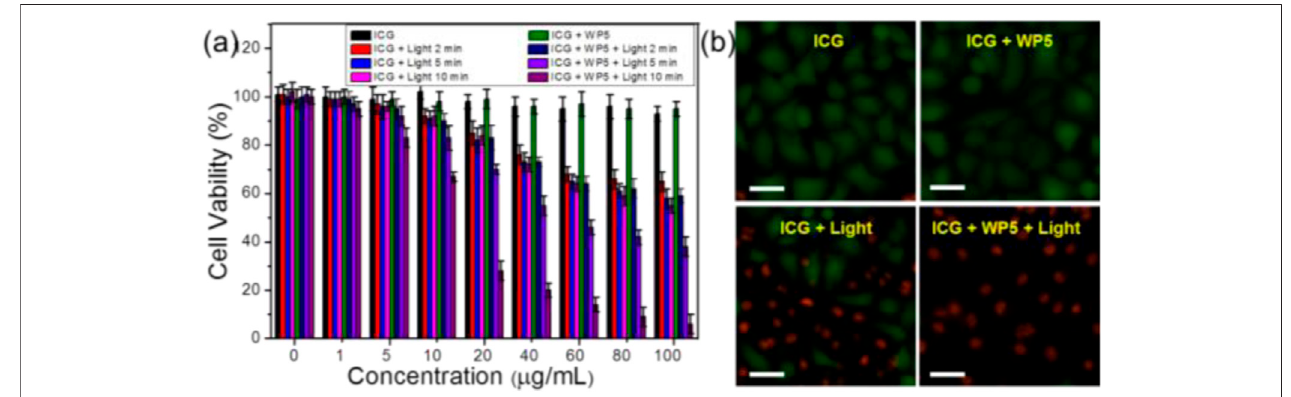
FIGURE 3 | (A) Cell viabilities of HeLa cells treated with different groups with 808 nm laser irradiation (1 W/cm 2 ). Error bars were based on the standard error of mean( n (cid:1) 4). (B) FluorescenceimagesofcalceinAM(livecells,green)andPI(deadcells,red)co-stainedHeLacellsafterdifferenttreatments(ICG (cid:1) 100 μ g/ml,irradiated for 10